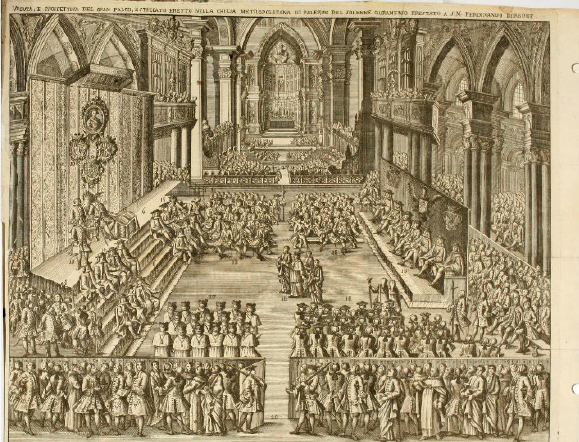
Figure 3. Antonio Bova’s view of the nave of the cathedral and the main apse (1760).